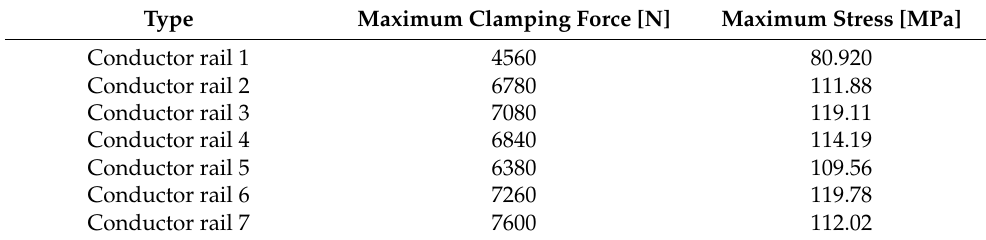
Table 3. Maximum clamping force and stress of conductor rails.